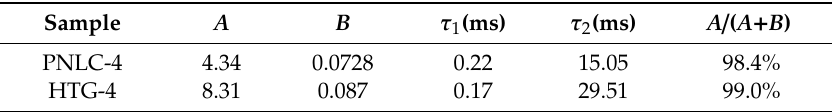
Table 4. Fitting parameters obtained through Equation